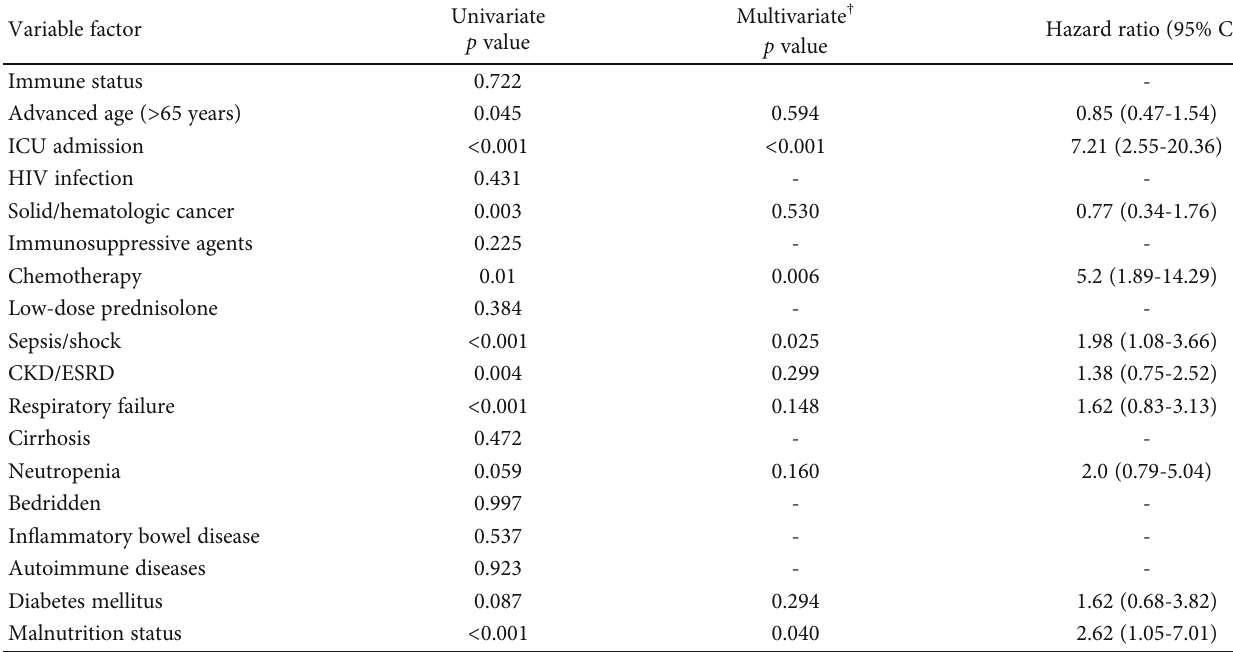
Table 5: Univariate and multivariate analyses (Cox proportional hazard model) to determine the predictive factors for inhospital